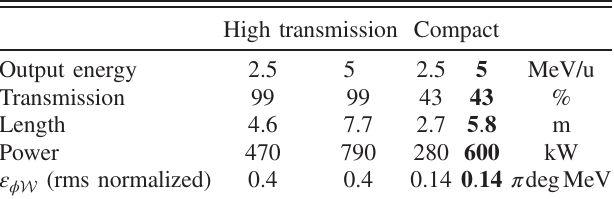
TABLE II. Values of transmission, length, power consumption and output longitudinal emittance for the considered RFQ design options with standard vanes. The final design choice is high- lighted in bold face.